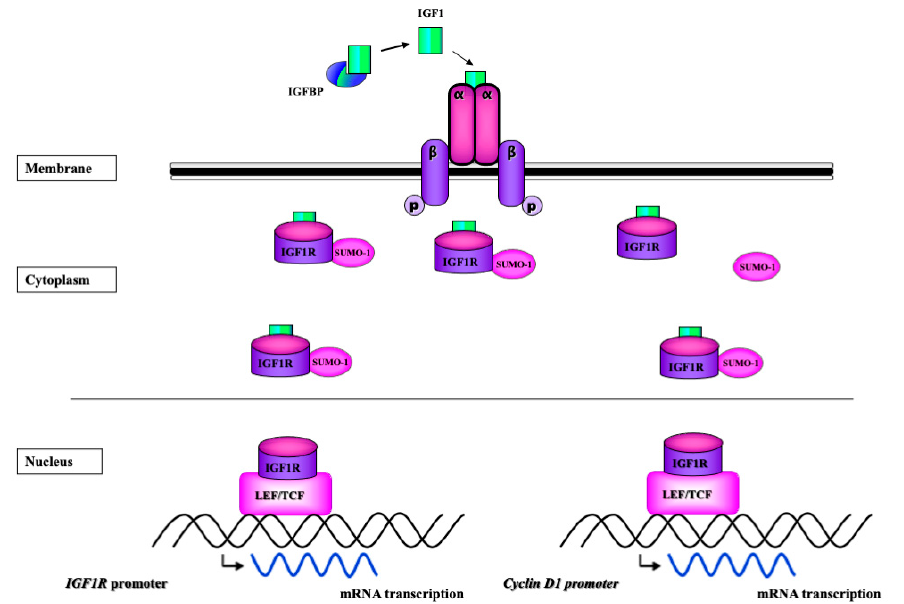
Figure 1. Schematic representation of IGF1R nuclear translocation. Nuclear IGF1R internalization is usually, but not nec- essarily, regarded as a ligand-dependent, SUMO-1-mediated translocation event. The intracellular domain of IGF1R in- cludes three lysine residues that appear to be involved in the interaction with SUMO-1. Nuclear IGF1R is capable of bind- ing DNA enhancer regions in a sequence-specific manner and as part of multimeric protein complexes. SUMOylated IGF1R binds to a LEF/TCF binding site in the cyclin D1 promoter, leading to enhanced gene activation. Nuclear IGF1R was shown to autoregulate expression of its own gene via interaction with